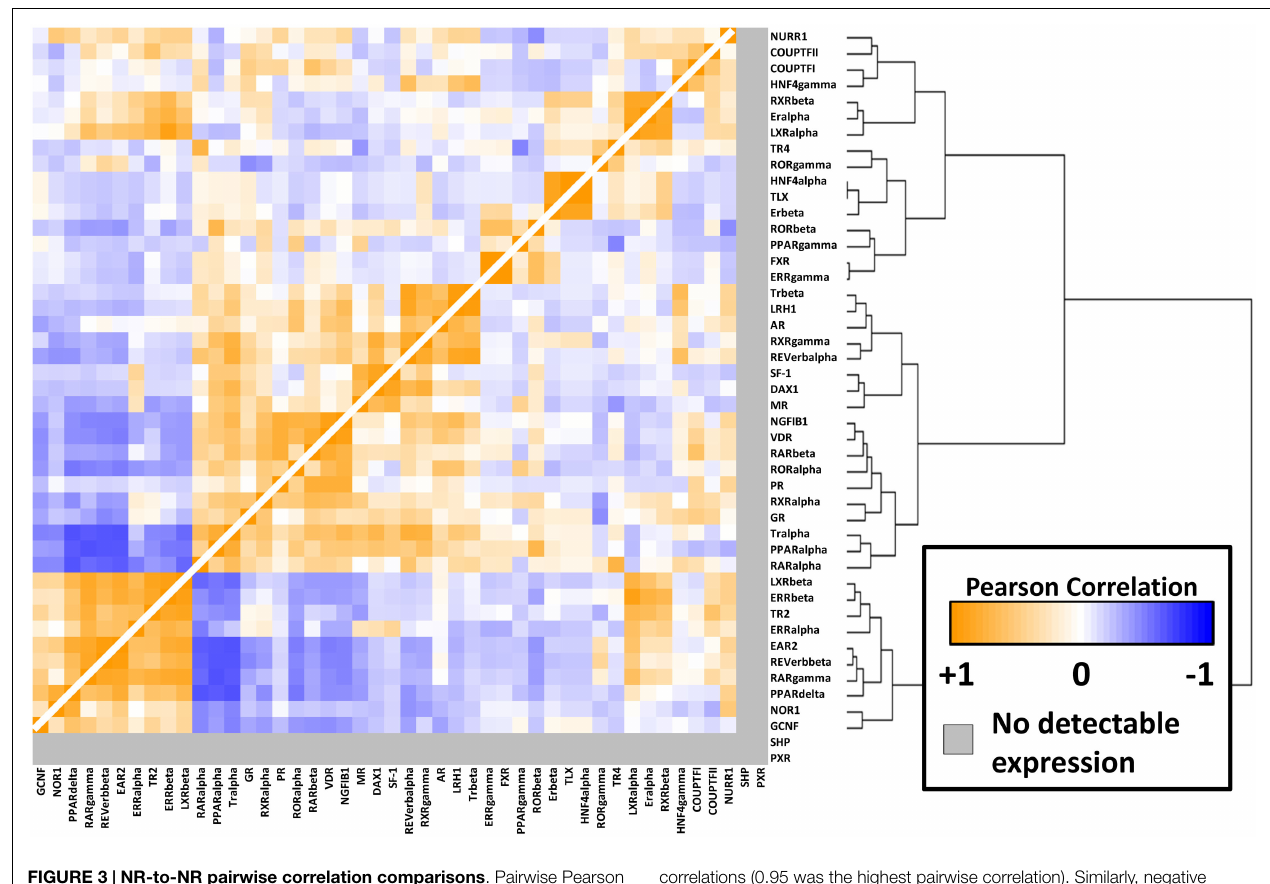
FIGURE 3 | NR-to-NR pairwise correlation comparisons . Pairwise Pearson correlation coefficient (PCC) analysis of the nuclear receptors. Hierarchical clustering analysis was performed as in Figure 1 . Positive correlations are depicted in orange with the strongest intensities corresponding to higher